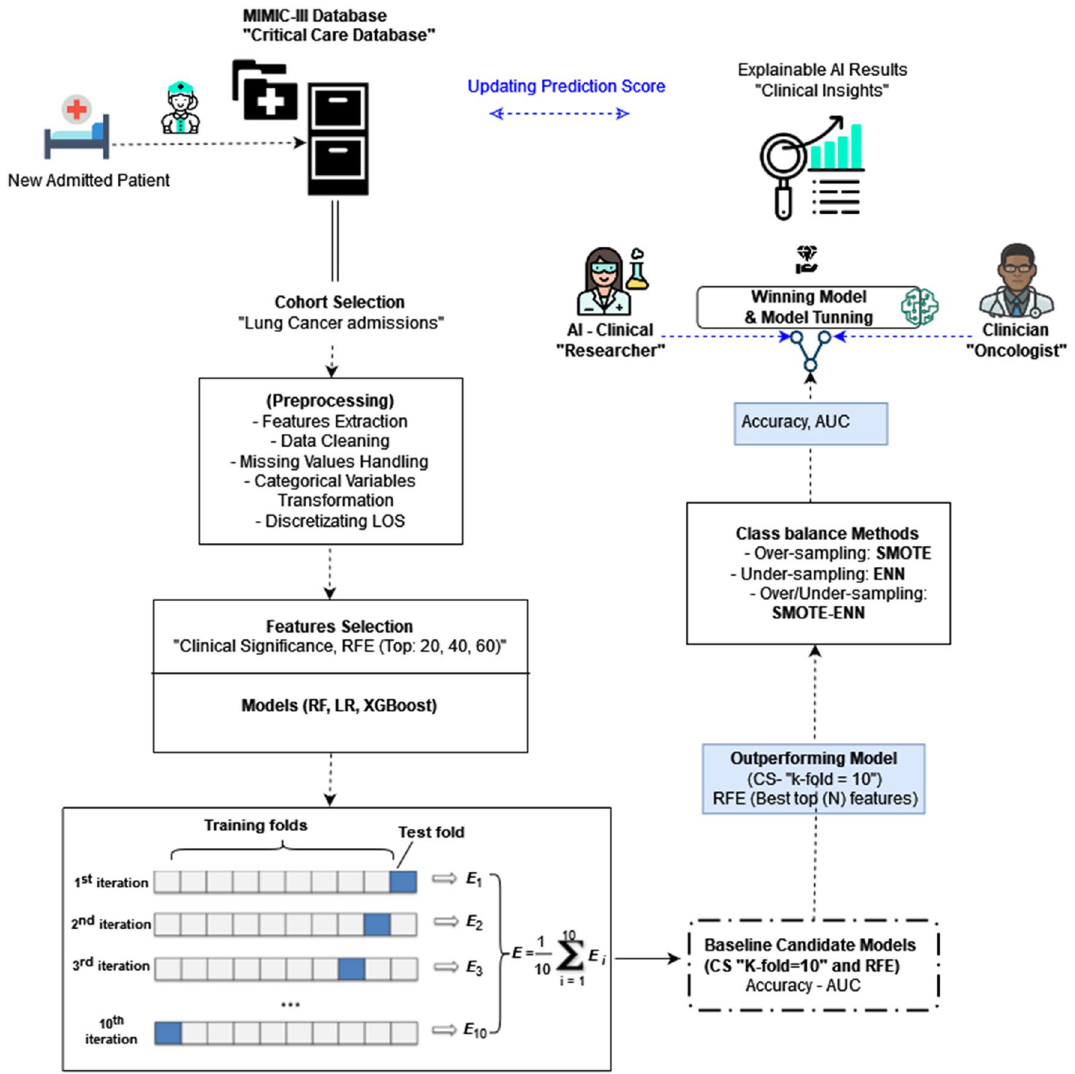
Figure 3. Lung cancer LOS predictive framework in ICU